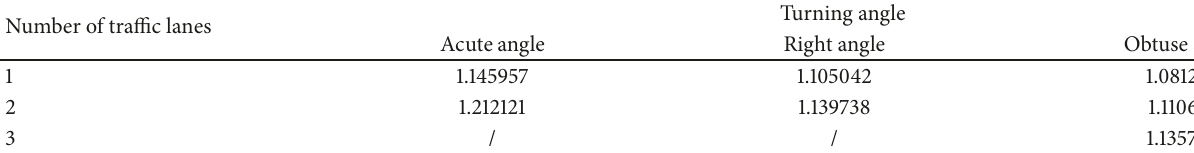
Table 6: Adjustment factor values of guideline markings for left-turns.